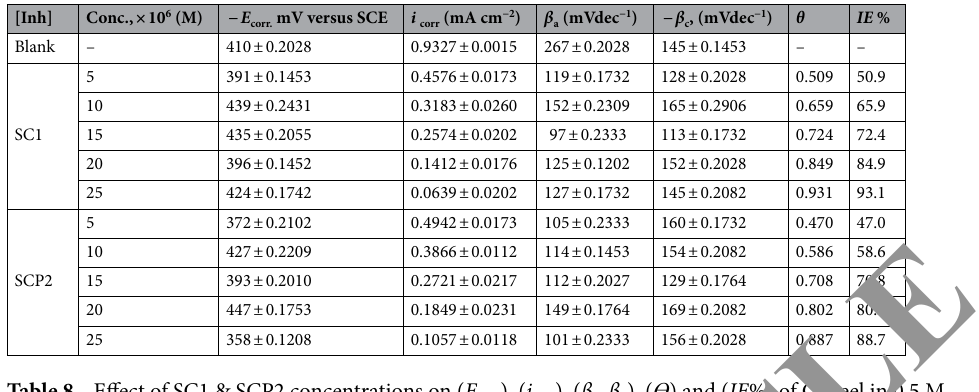
Table 8. Effect of SC1 & SCP2 concentrations on ( E corr ), ( i corr ), ( β c , β a ), ( ϴ ) and ( IE %) of C-steel in 0.5 M H 2 SO 4 at 298 K.